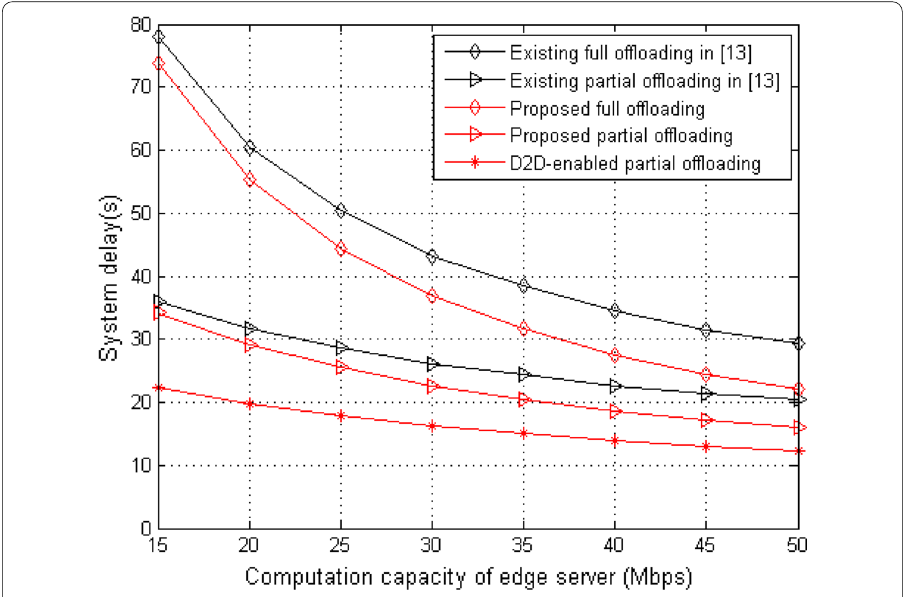
Fig. 7 The system delay with the computation capacity of the edge server with K